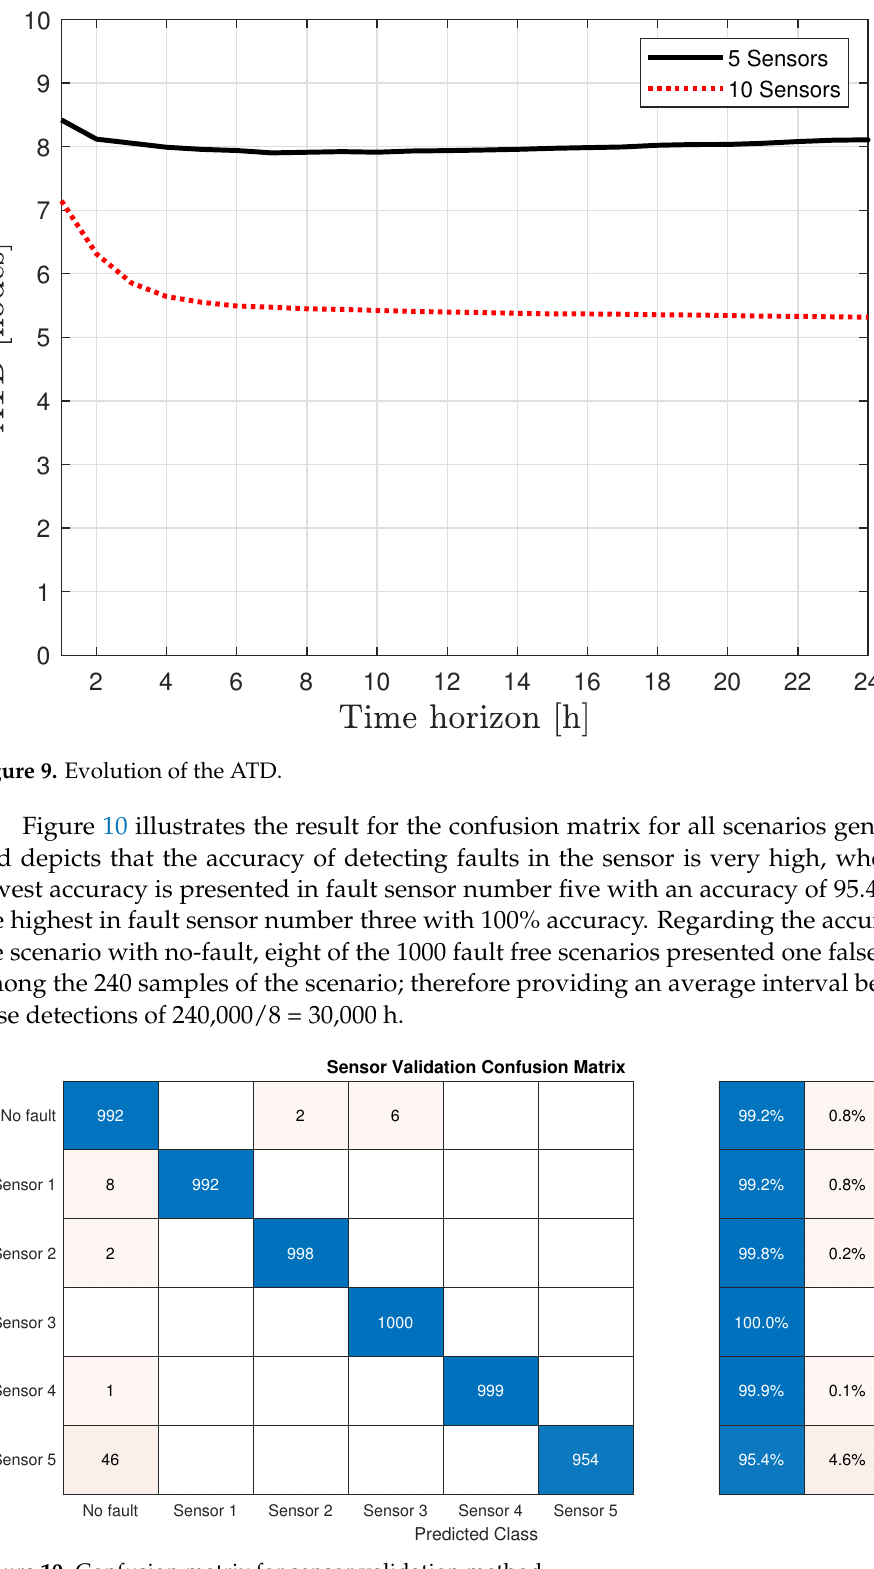
Figure 10. Confusion matrix for sensor validation